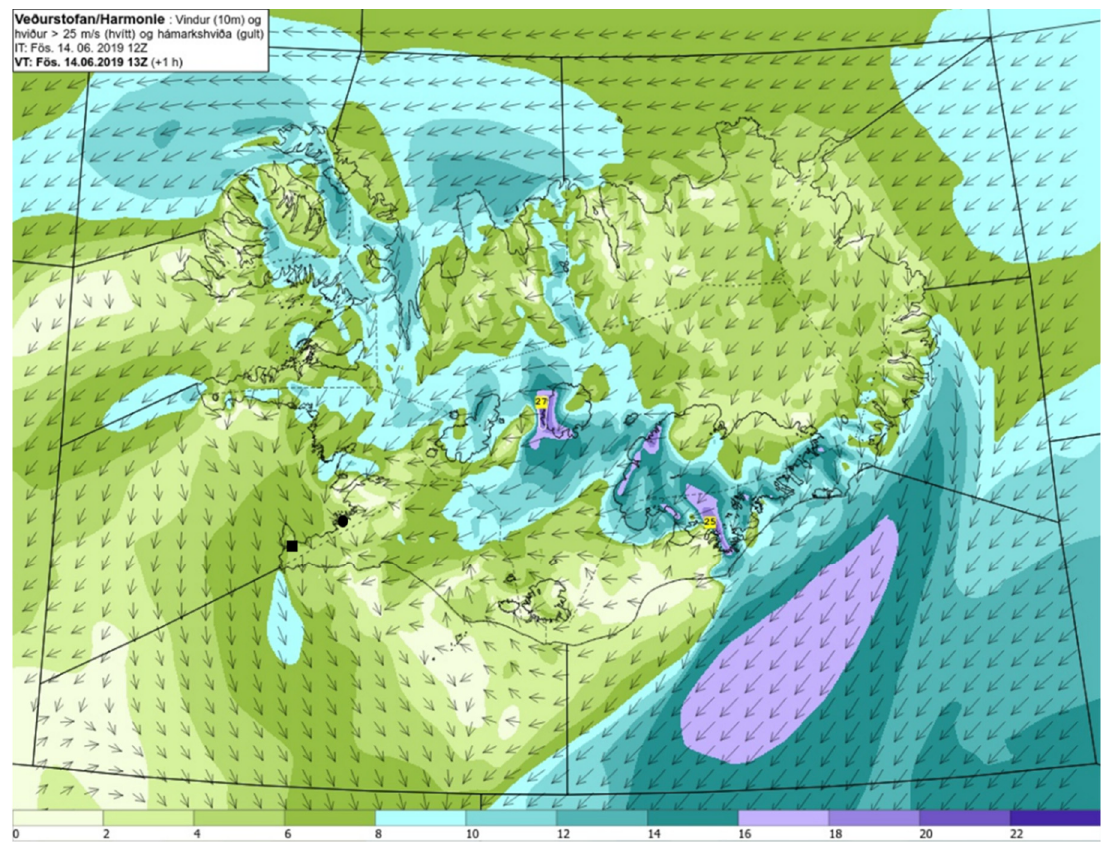
Figure 4. Wind conditions during the June case. This is a HARMONIE-AROME model forecast of 10 m wind at 13 UTC, 14 June, 2019. The arrows indicate the wind direction while the colours indicate the wind speed [m s − 1 ]. The black dot and square indicate the locations of RVK and KEF, respectively.